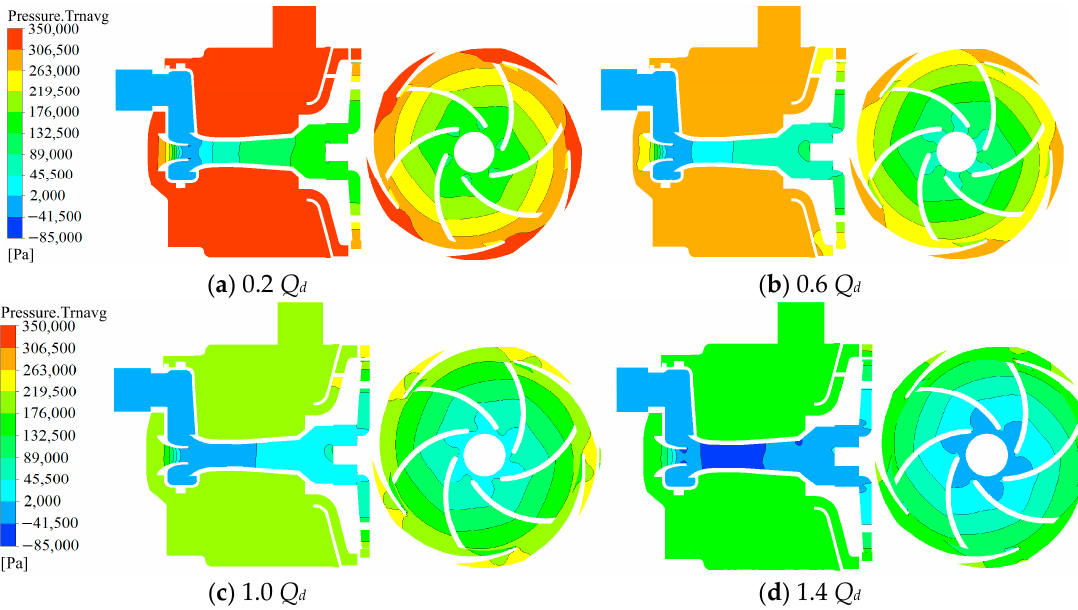
Figure 5. Time-averaged distribution contours of pressure on two planes under four conditions.